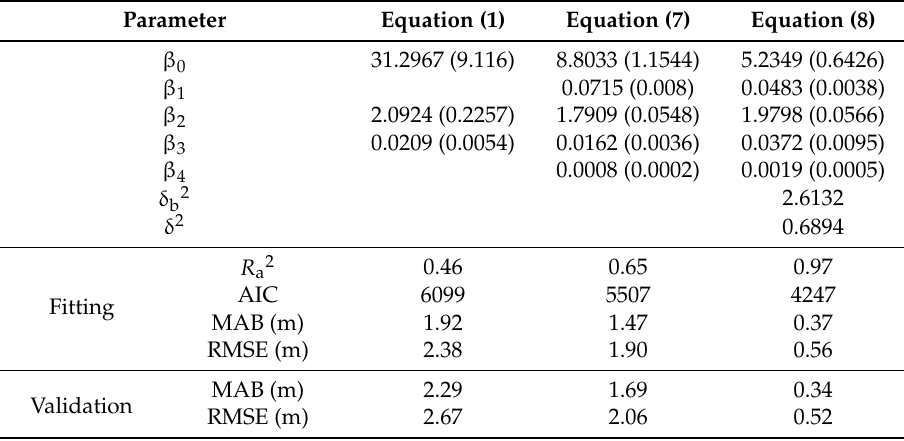
Table 2. Parameter estimates and statistical